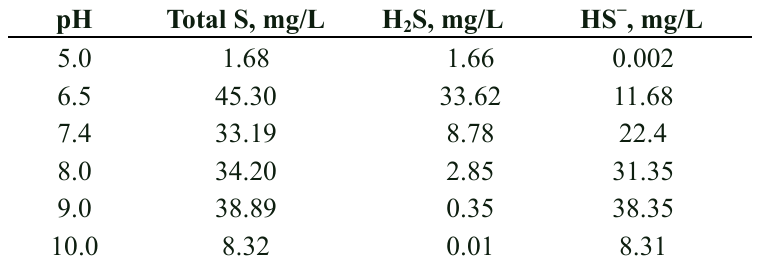
Table 1. EC values of sulfide to Q67 with the concentration distribution in various 50 pH